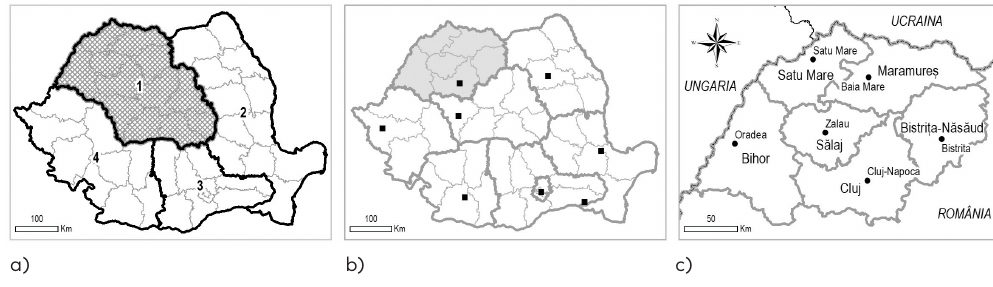
Figure 1. The North-West Region of Romania: a) Macroregion 1; b)